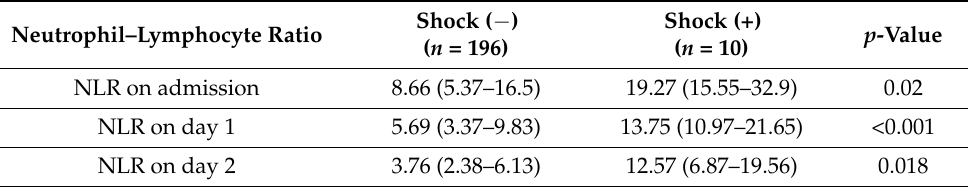
Table 4. Sequential changes in the neutrophil–lymphocyte ratio of acute cholangitis with and without shock